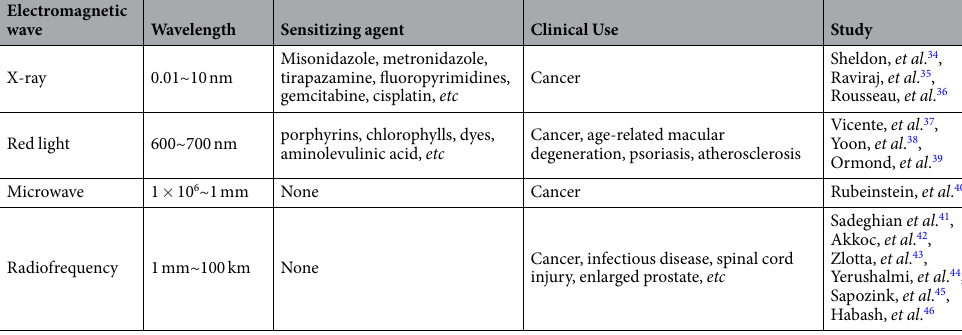
Table 2. Electromagnetic waves widely used in modern medicine. The clinical applications of electromagnetic wave in modern medicine are summarized from previously published data 34–46